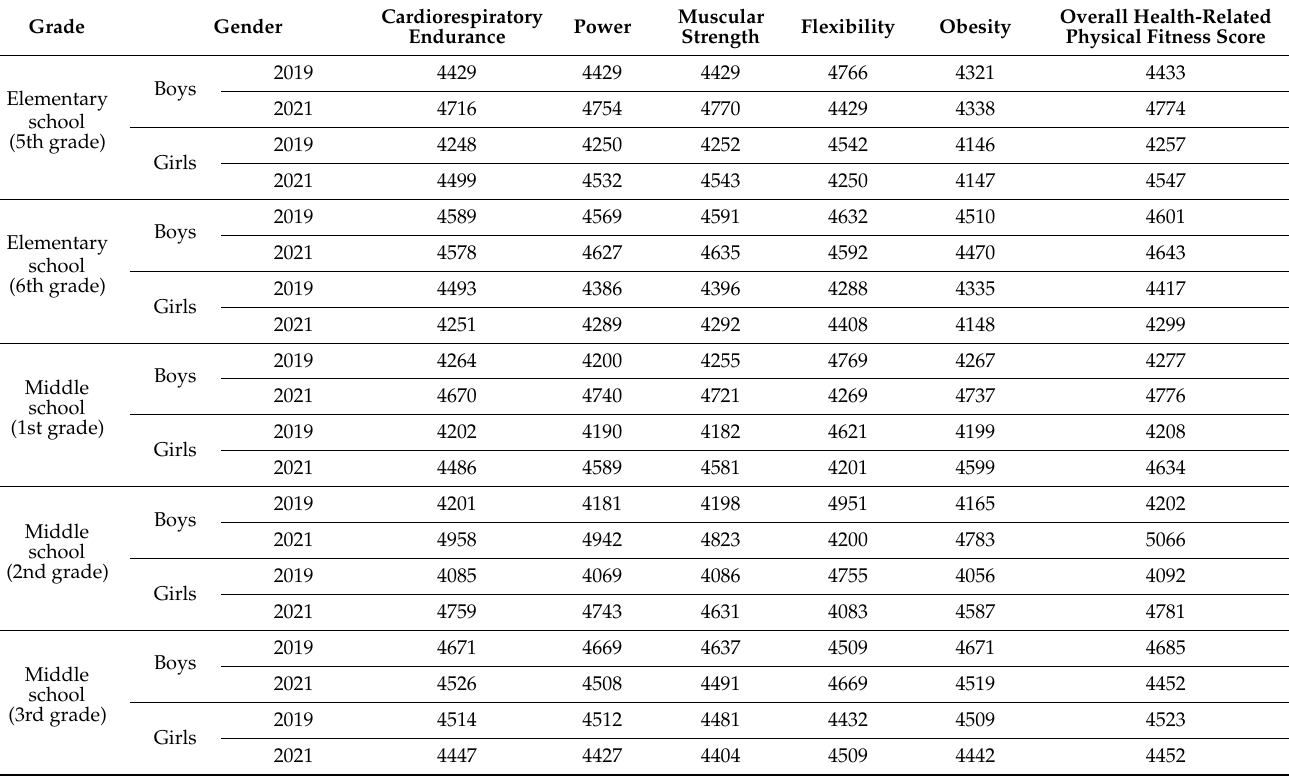
Table 1. Number of study participants between 2019 and